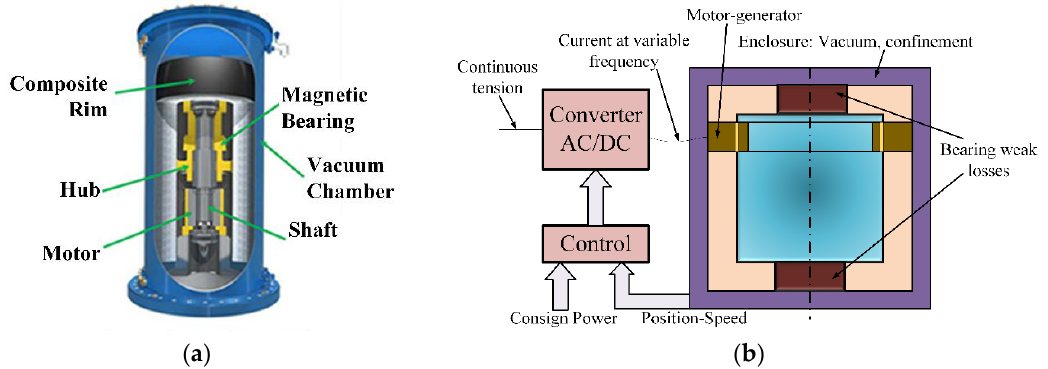
Figure 10. ( a ) Flywheel energy storage system where energy is stored as rotational kinetic energy of a cylinder in vacuum; ( b ) schematic diagram of flywheel energy storage (FES), also called accumulator [37]. Table 4. Comparison among the characteristics of low-speed and high-speed flywheel energy storage system (FESS) [42].